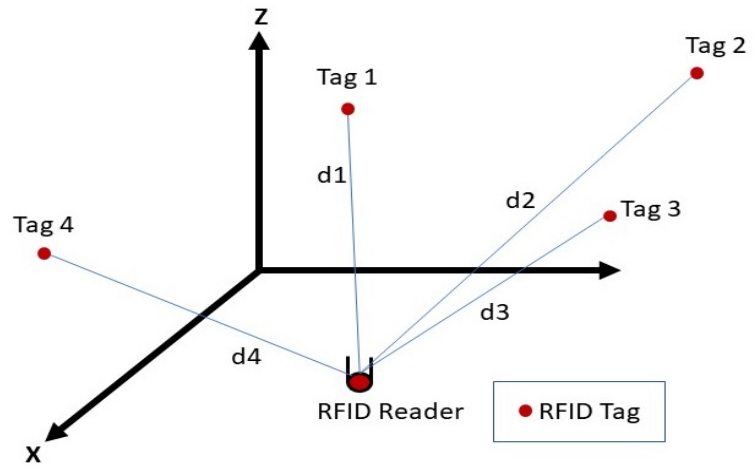
Figure 10. Multilateration technique using four independent tags.